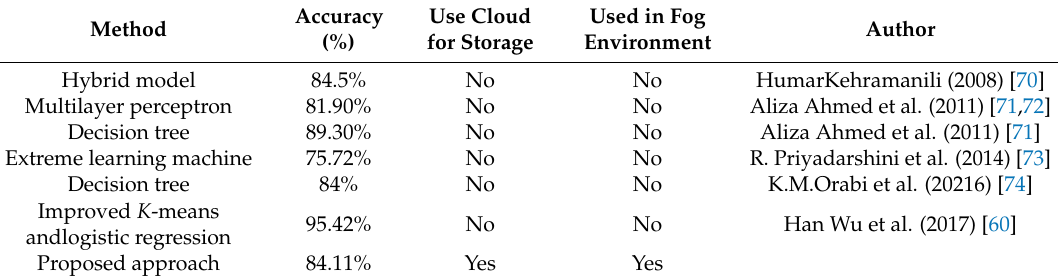
Table 9. Comparative analysis of diabetes prediction.